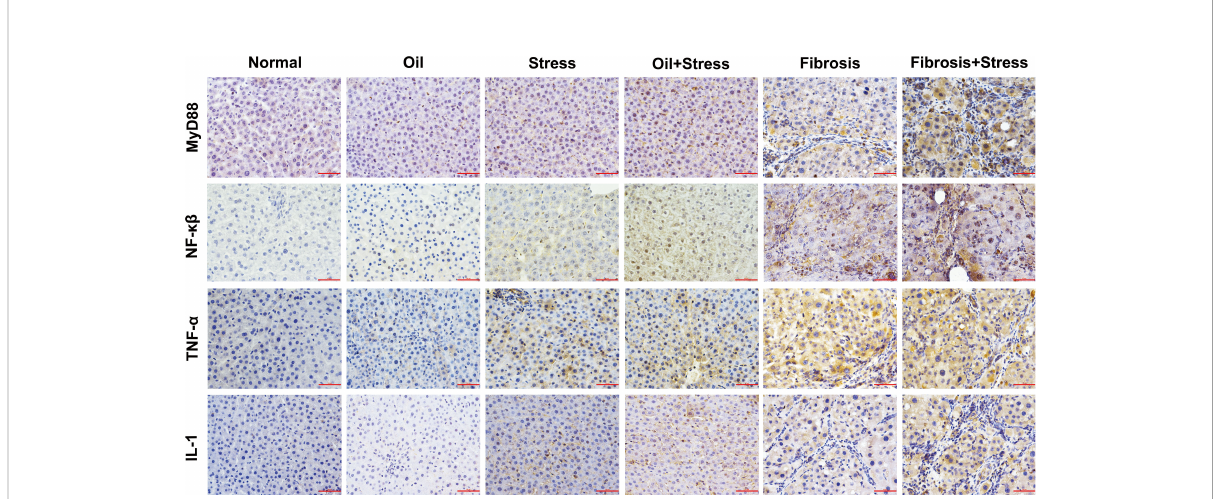
FIGURE 6 Immunohistochemical staining of MyD88, NF- kb , TNF- a and IL-1 proteins in LPS-TLR4 pathway depend on MyD88 in liver tissue of rats. Scale bar: 50um. MyD88, myeloid differentiation factor 88; NF- kb , nuclear factor kappa b ; TNF- a , tumor necrosis factor a ; IL-1, interleukin